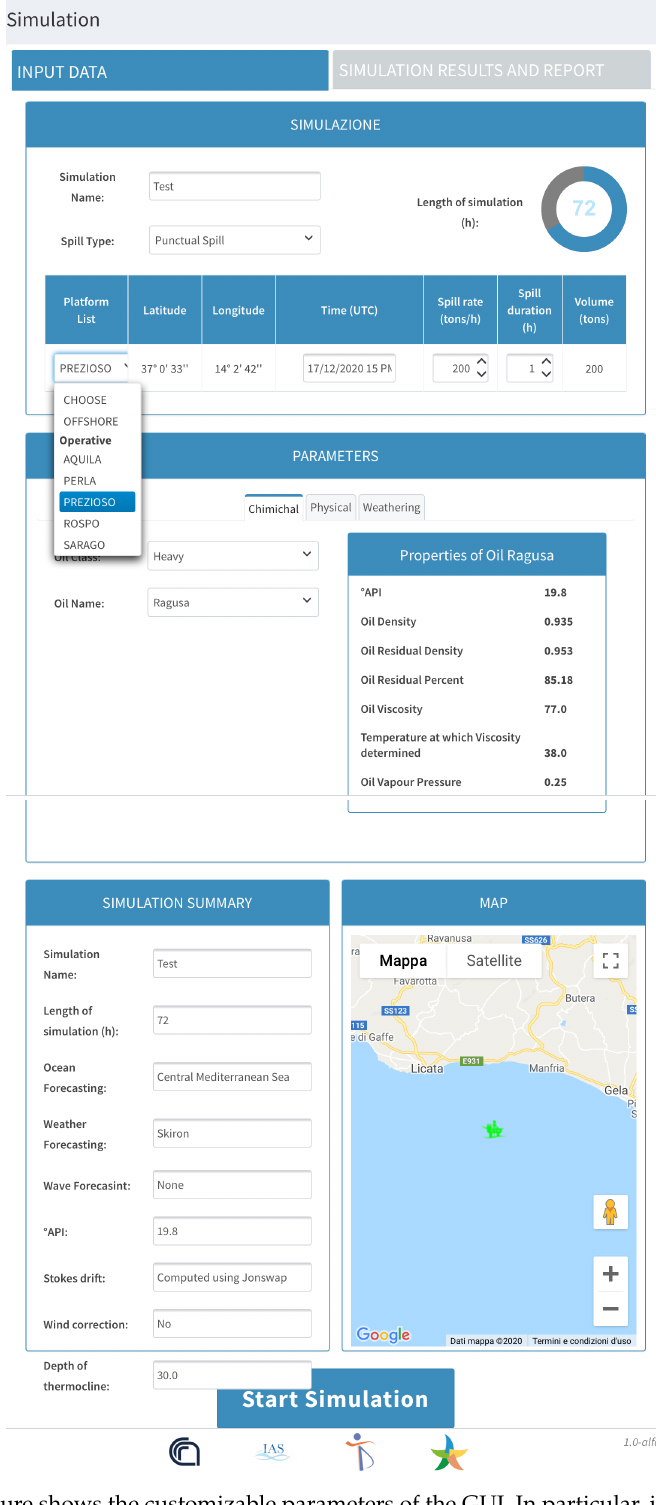
Figure 4. The figure shows the customizable parameters of the GUI. In particular, in the first part the end user may choose the type of the simulation (spill type, length of simulation and eventually the platform with the relative coordinates); in the second part the chemico-physical parameters of the simulation, such as the oil type and its name. At the end, before starting the simulation, the end user can verify the settings in the summary of the simulation and on the